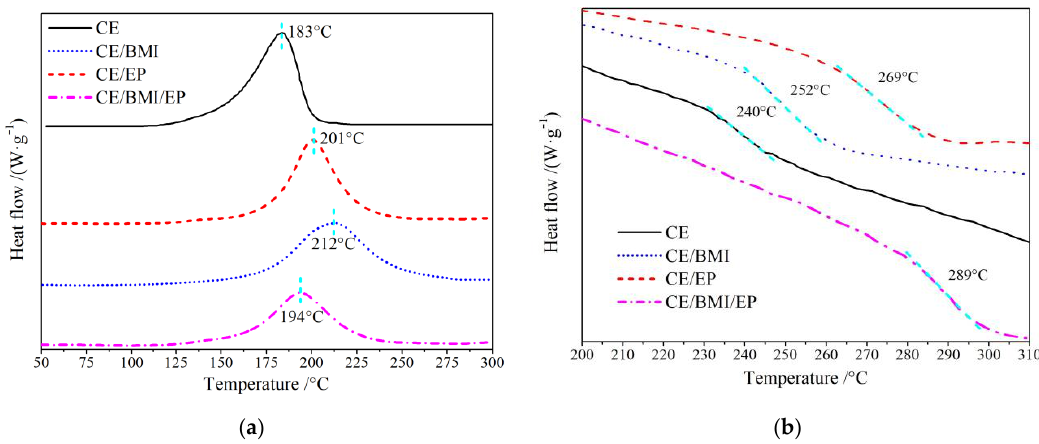
Figure 4. Dynamic differential scanning calorimetry (DSC) exothermic temperature spectra: ( a ) in curing process and ( b ) glass transition of the cured materials for the pure CE and CE/EP, CE/BMI, CE/BMI/EP composites.